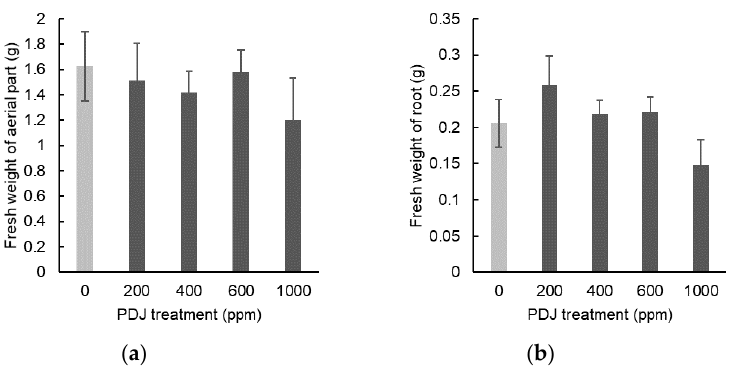
Figure 8. Weight of aerial parts ( a ) and roots ( b ) of eggplant seedlings treated with PDJ applied drip-wise at various concentrations. Eggplant seeds were germinated and grown in soil. PDJ was applied drip-wise at concentrations of 200, 400, 600, and 1000 ppm to seedlings at 1 week before harvest. Weight of aerial parts (a) and roots (b) are shown as the average value ( n = 4) measured on the final day of pot culture (day 28). Error bars indicate standard error (SE).